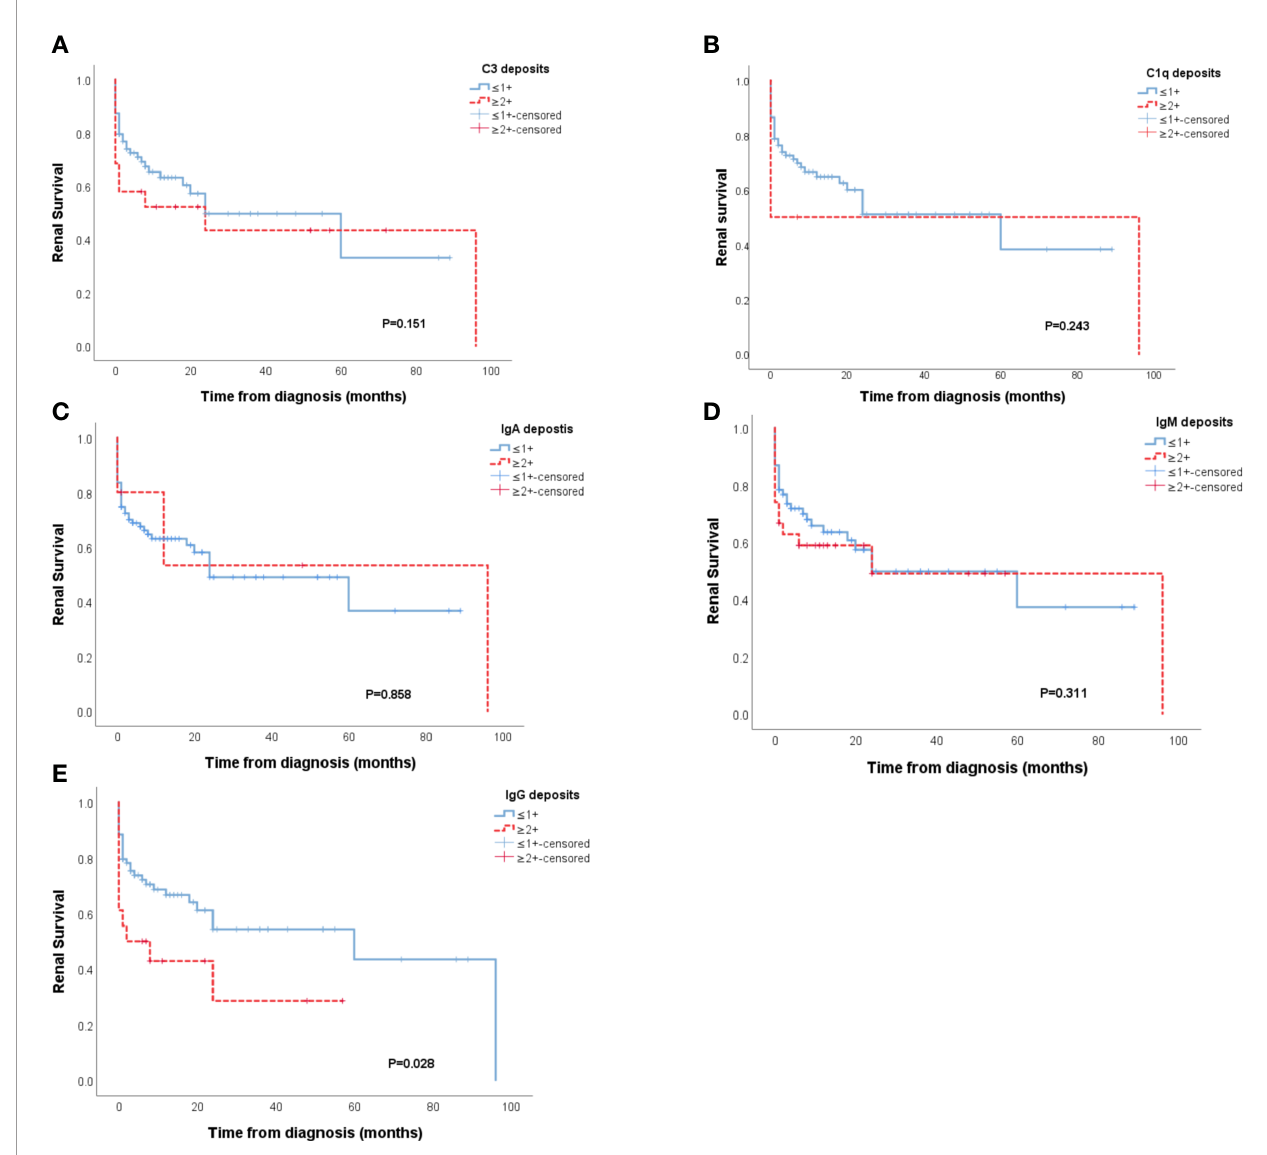
FIGURE 3 | Renal survival of patients with and without C3, C1q, IgA, IgM deposits (A – D) . Patients with IgG deposits showed poorer renal prognosis than patients that had no or low IgG deposits in the glomeruli (p = 0.028) (E)